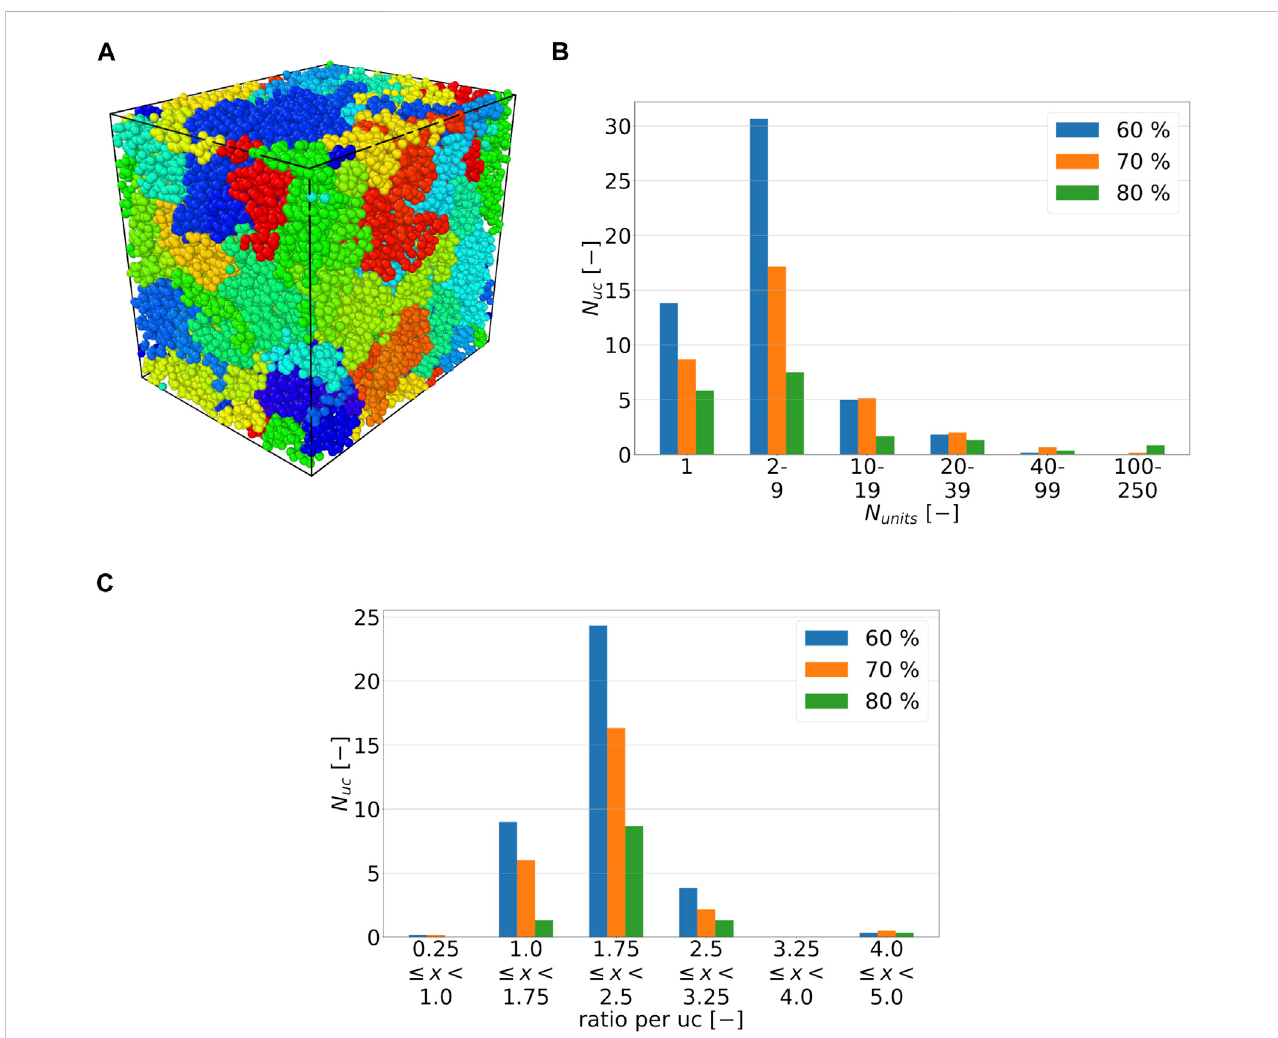
FIGURE 3 (A) RVE with cdc of 80 percent for chain to linker ratio of 2 to 1. The different colors of the atoms de fi ne the cross-linked polymer chains and linkers and arereferredtoasunitchainsinthefollowing.Inthisexample,42differentunitchainsexist. (B) Averagehistogramplotofnumberofunits N units ,chainorlinker, per unit chain (uc) for ratio of 2 to 1. A chain unit consists of connected chains and linkers. The standard deviations of the number of units per unit chain are 5.75, 12.86, and 39.55 for a cdc of 60, 70, and 80 percent, respectively. (C) Average histogram plot of chain to linker ratio per unit chain for ratio of 2 to